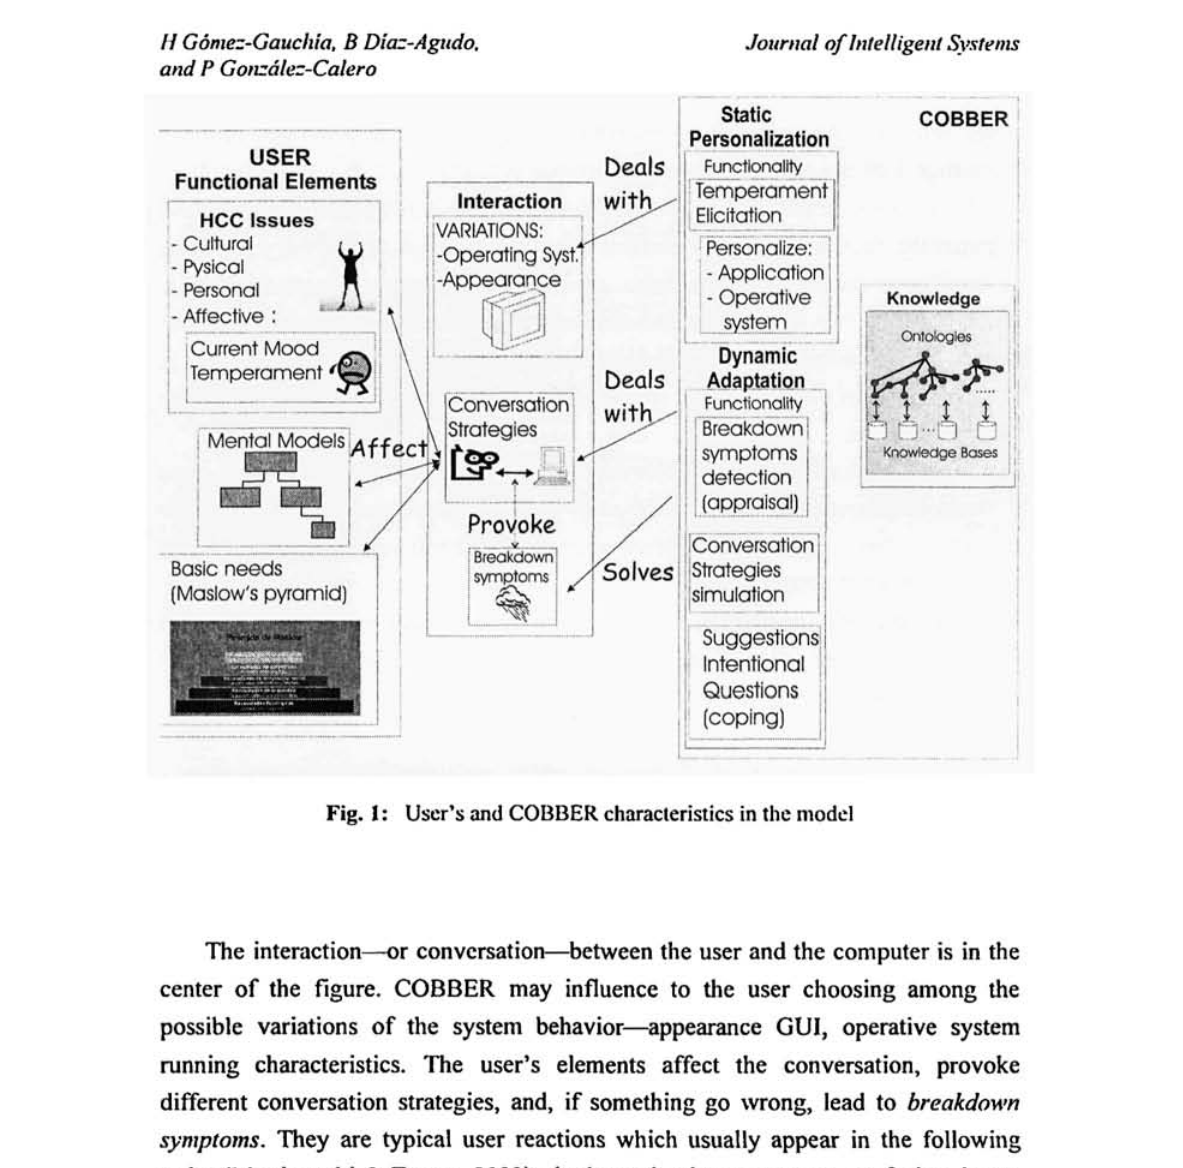
Fig. I: User's and COBBER characteristics in the